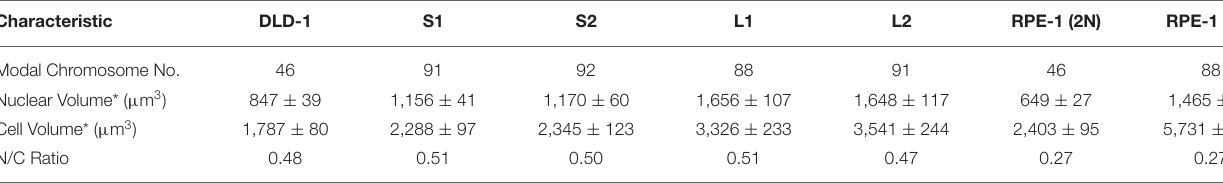
TABLE 2 | Characterization of parental DLD-1 and RPE-1 cells and derived tetraploid clones. Characteristic DLD-1 S1 S2 L1 RPE-1 (4N) Modal Chromosome